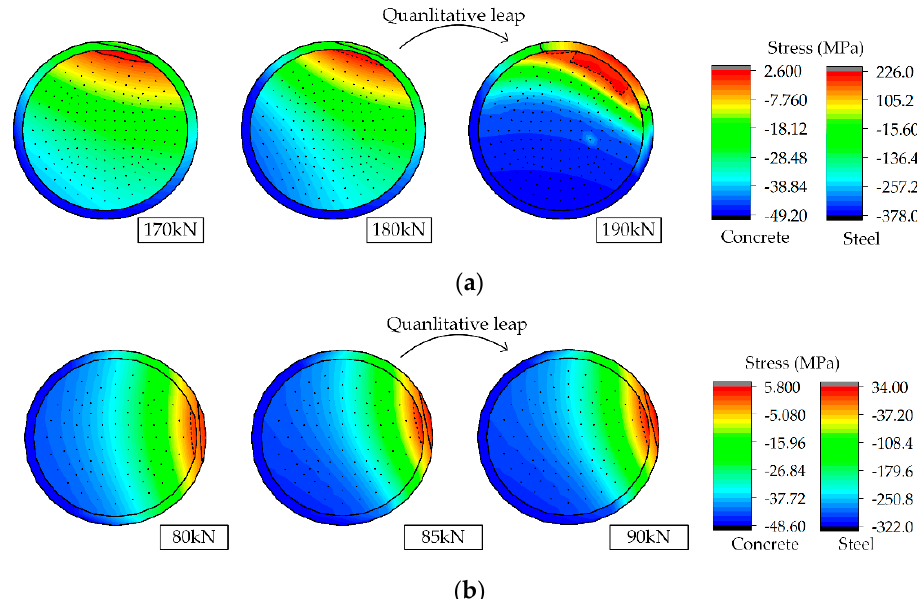
Figure 11. Stress fields of arch models around characteristic loads Q : ( a ) Section 11 of arch-A; ( b ) Section 13 of arch-B.